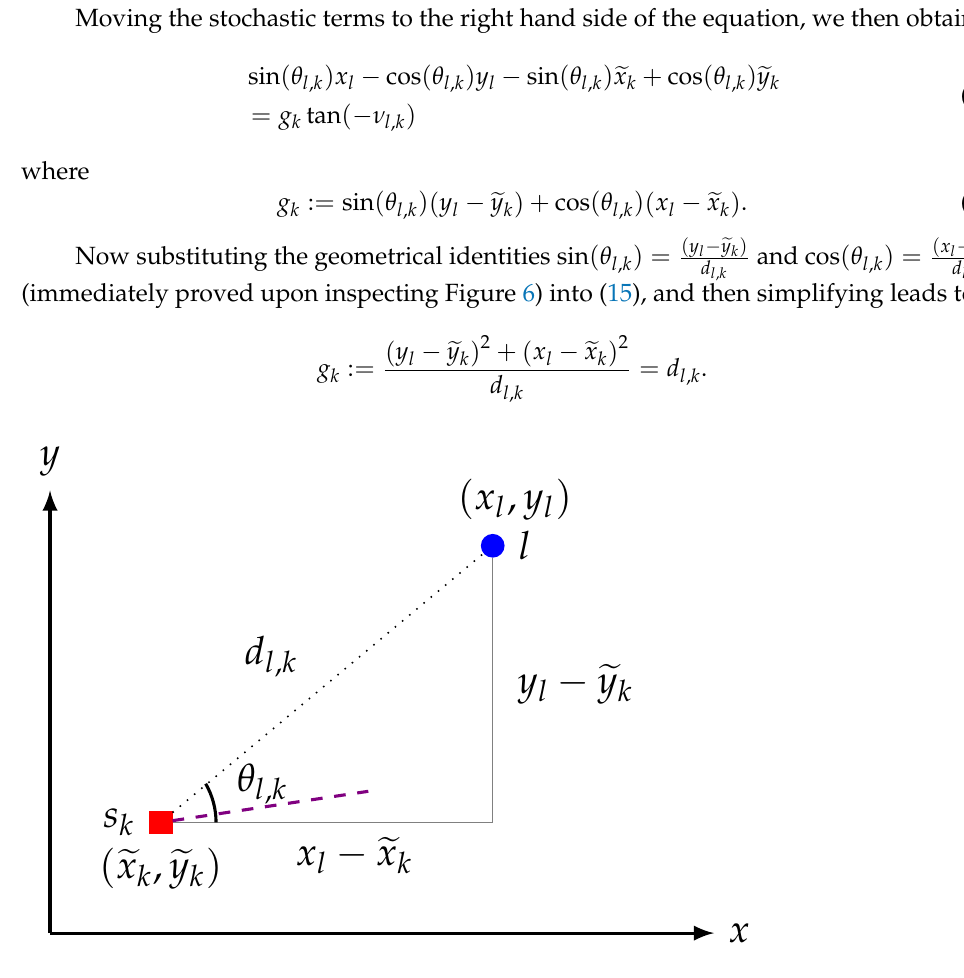
Figure 6. A simplified diagram illustrating the geometrical relation between the angle θ l , k , s k , d l , k and the landmark position in the noiseless case. The dashed line in the plot indicates the robot heading direction, while the dotted line represents the sensor to landmark true distance.